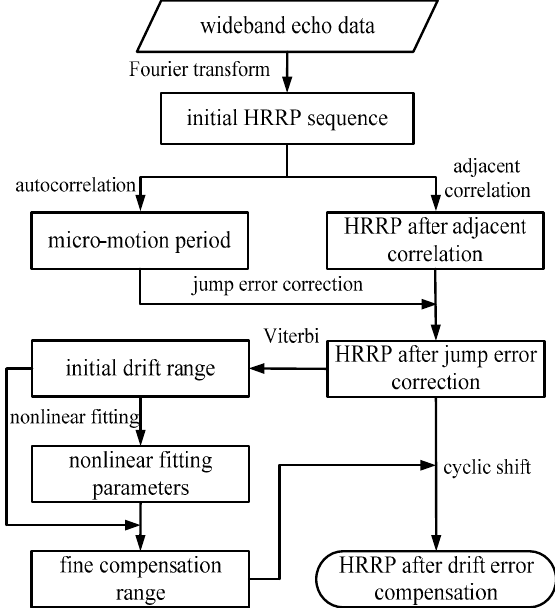
Figure 3. Flow diagram of the envelope correction method.